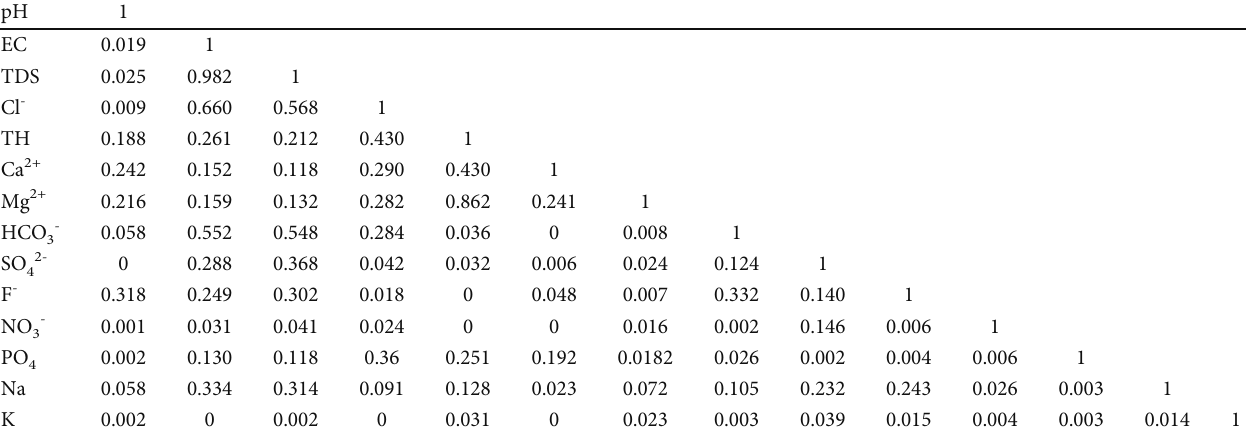
Table 3: The coe ffi cients of correlation ( r ) between several water quality metric postmonsoon.